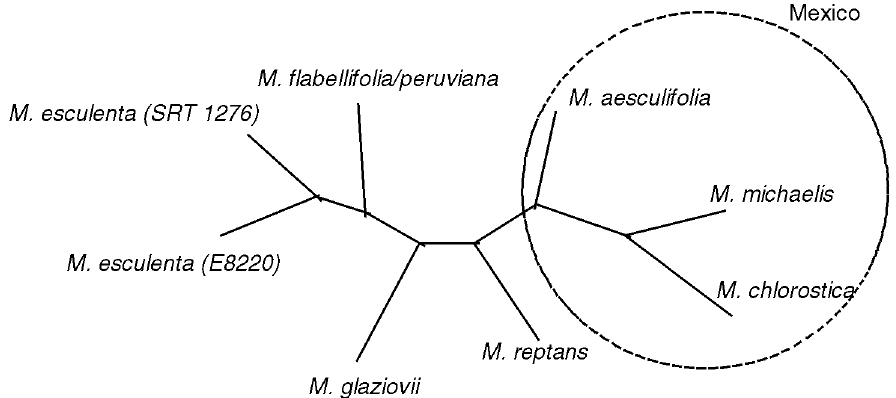
Figure 3 - Unrooted tree classification of cassava and other wild species of Manihot elaborated by the neighbor-joining method using the similarity coefficients of Jaccard derived from RAPD